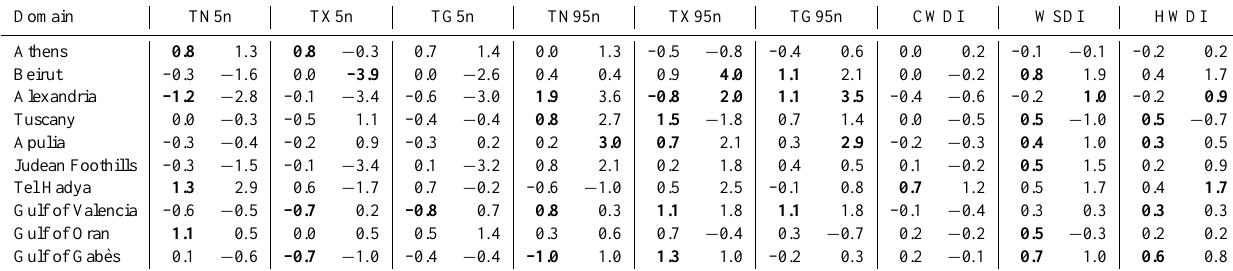
Table 5. For each extreme, trends over 1958–2008 (left column) and 1989–2008 (right column) are given. Domain